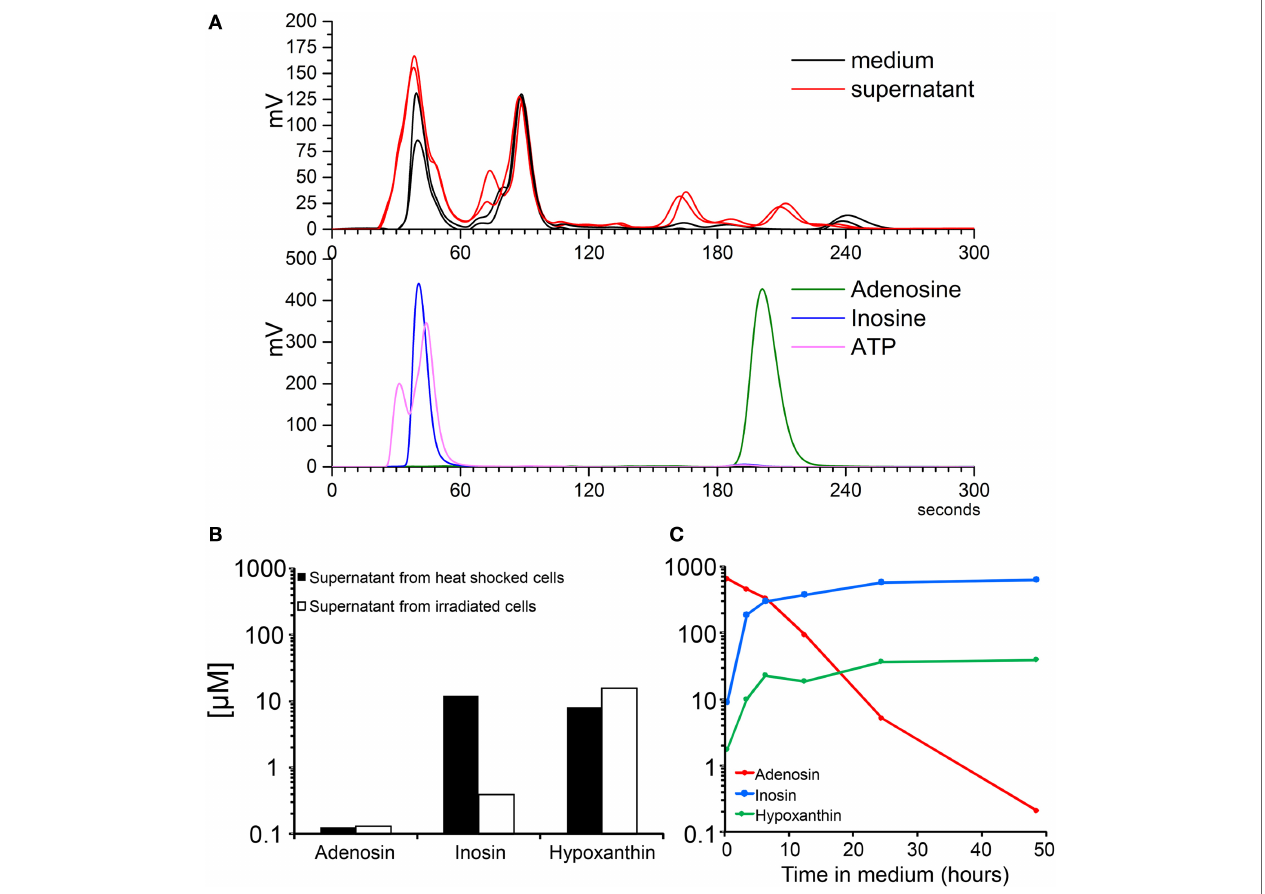
FigUre 3 | Molecular analysis of the protein-free fraction of supernatants (sns) from dying cells . Electrograms of SNs of B16F10 cells after 24 h of irradiation and metabolite standards by high-performance liquid chromatography (a) . Concentrations of nucleosides measured by mass spectrometry of SNs of B16F10 cells after 24 h of irradiation and 1 h after heat shock (B) . Spontaneous adenosine degradation into its metabolites inosine and hypoxanthine in SN spiked with 500 µM of adenosine and measured by mass spectrometry (c)